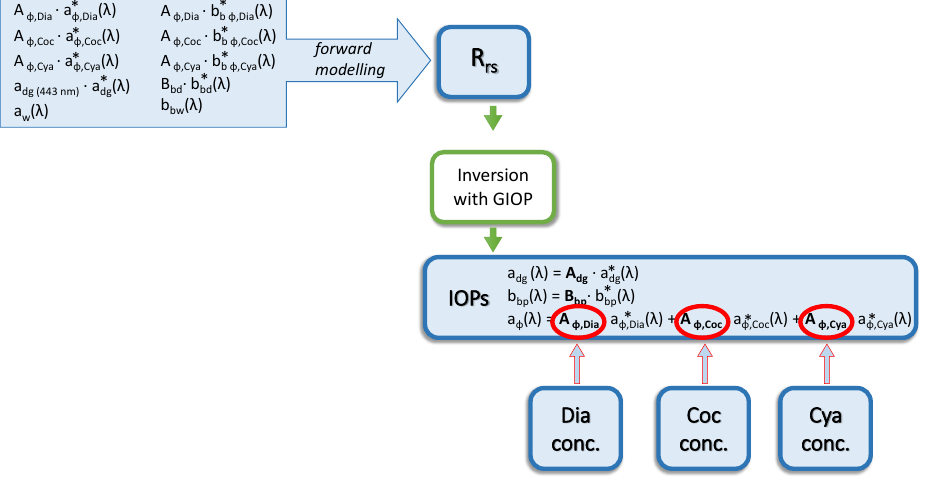
Figure 3. Flowchart showing the inversion performed with